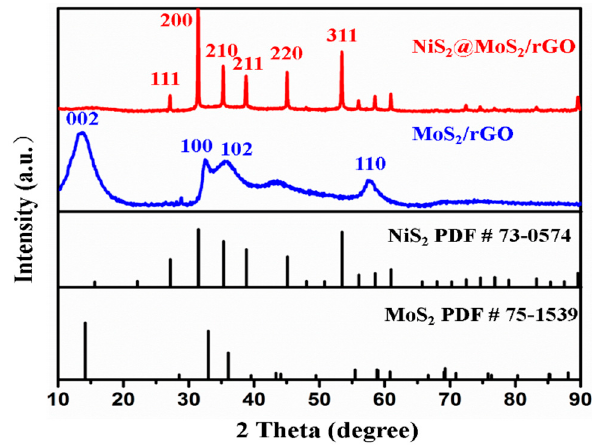
Figure 2. XRD patterns of MoS 2 /rGO and NiS 2 @MoS 2 /rGO composites.